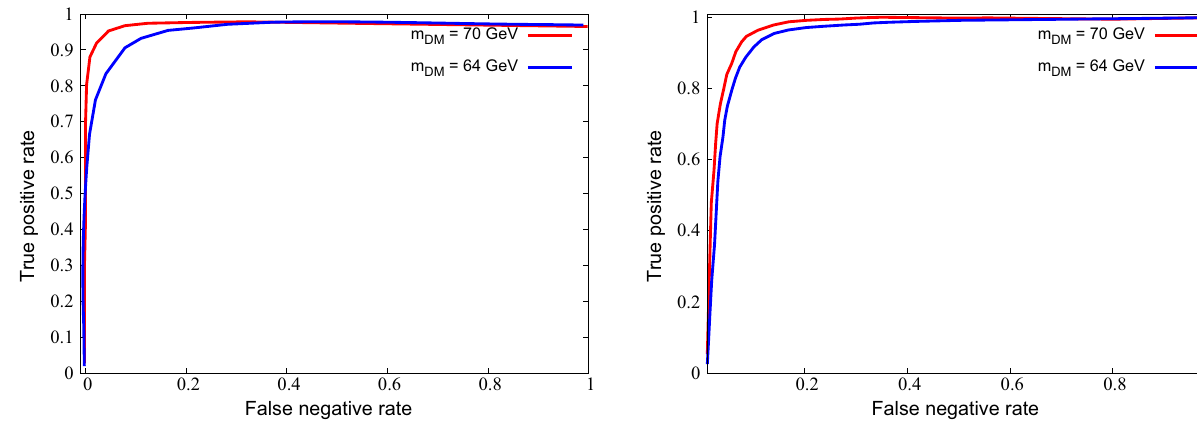
Fig. 17 ROC curves for two Dark matter masses in the γγ + / E T final state with ANN(left) and BDT(right) Table 8 The S / B ratio and signal significance for the benchmark points at 13 TeV with L = 3000 fb − 1 in the γγ + / E T final state, using ML. A comparison between BDT, ANN and cut-and-count(CC) results are presented in last three columns, in terms of the ratio of respective signal significance Table 9 Feature variables for training in the ML analysis for the b ¯ b + / E T channel. The observables which were used in the cut-based analysis have been separated from the new ones by a horizontal